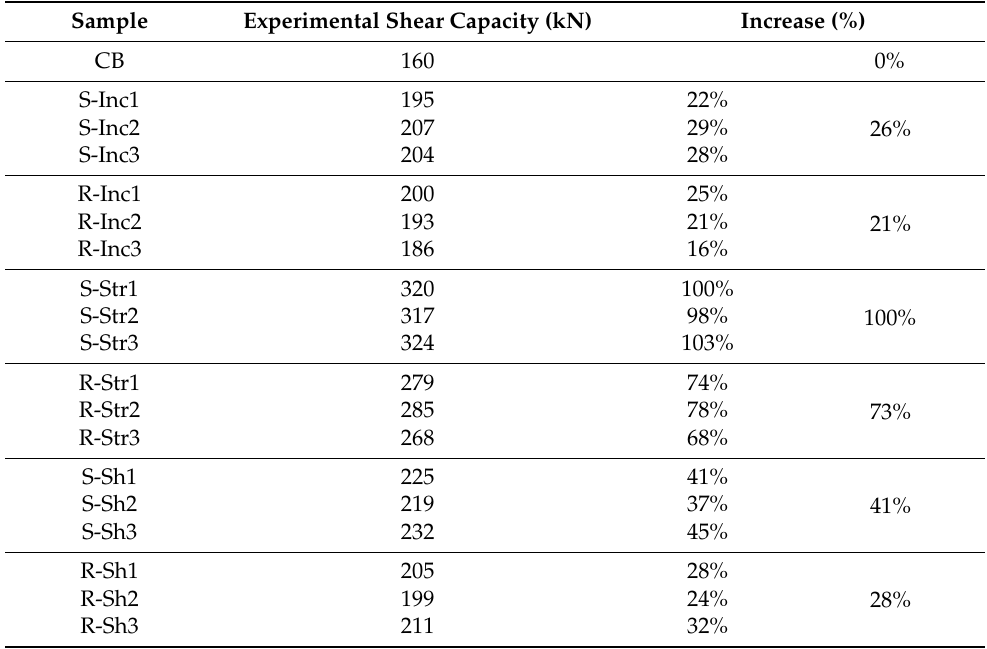
Table 8. Experimental test results.